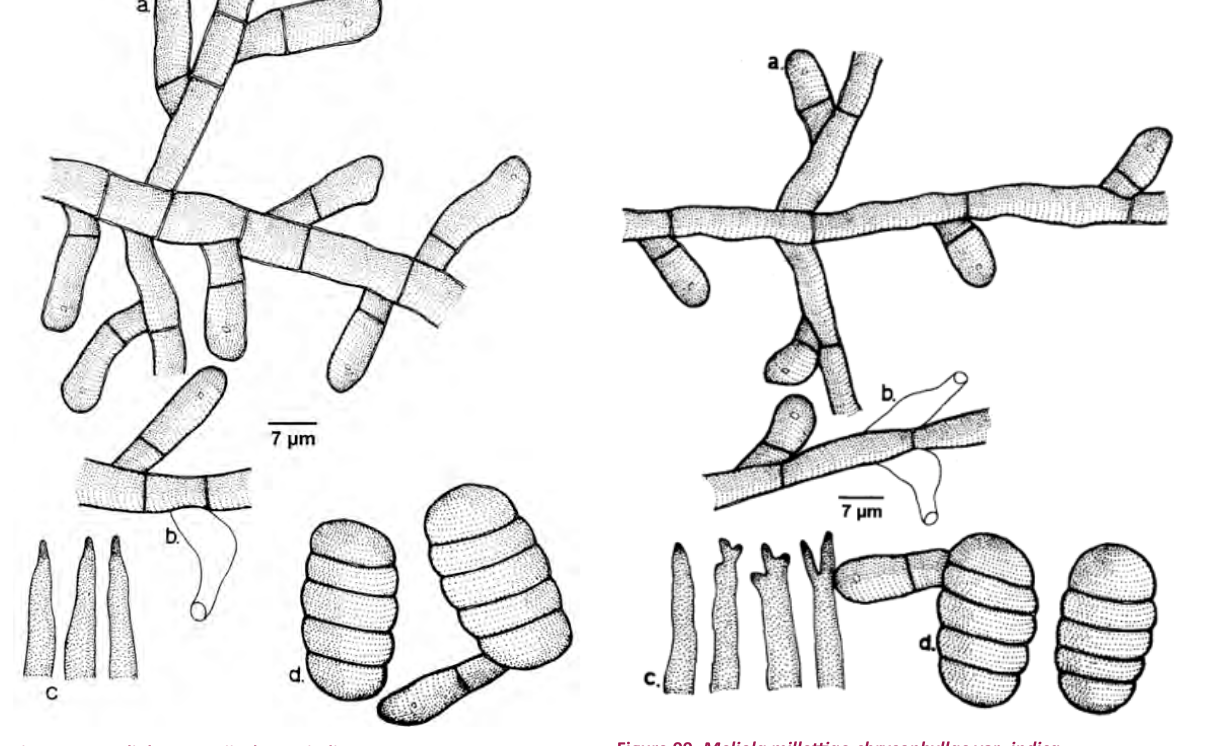
Figure 98. Meliola mayapiicola var. indica a - Appressorium; b - Phialide; c - Apical portion of mycelial setae; d - Ascospores